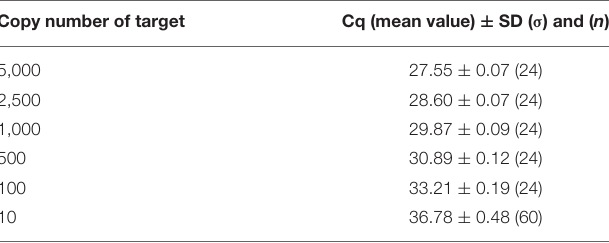
TABLE 10 | Cq values obtained on dilutions of genomic material used for efficiency calculation and for LOD 95 % for the transferability